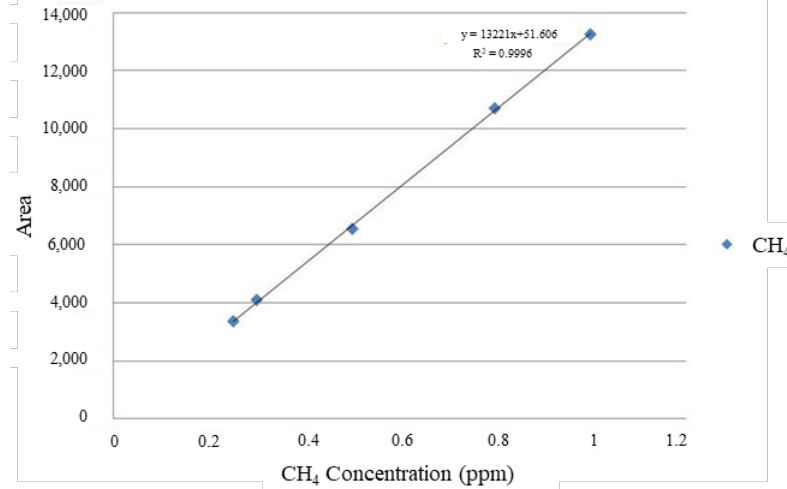
Figure 5. Calibration curve for CH 4 using the standard gas.